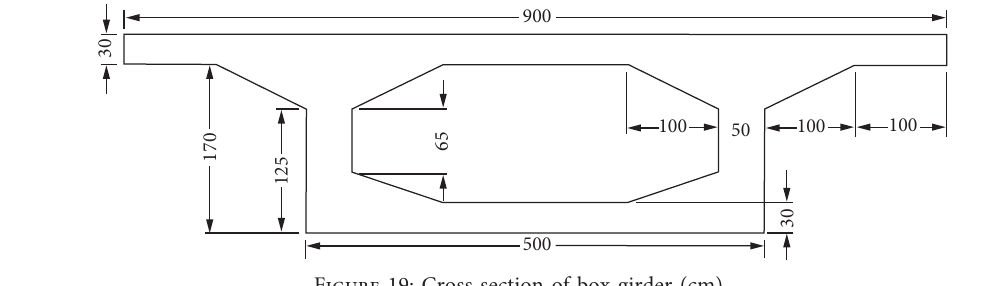
Figure 19: Cross section of box girder (cm).